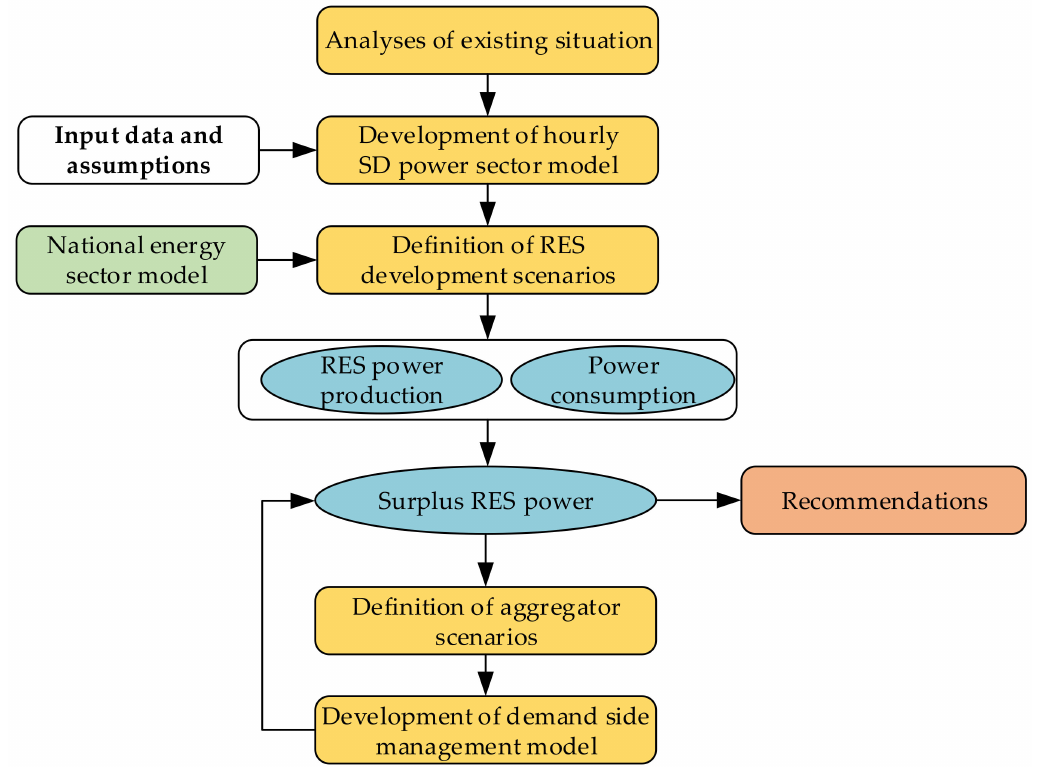
Figure 3. Research